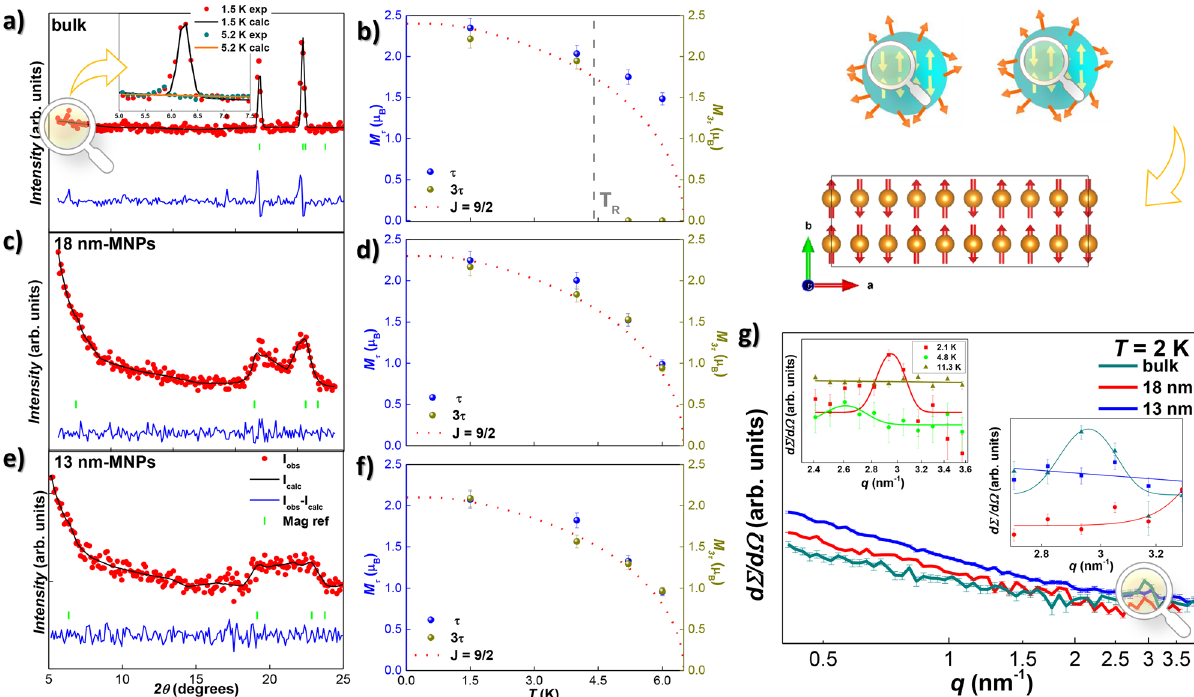
Figure 1. Neutron diffraction results. ( a , c , e ) Experimental neutron diffraction patterns at T = 5.2 K (red dots), together with the Rietveld refinements (black lines) measured for bulk NdCu 2 , 18 nm and 13 nm-sized MNPs, respectively. Inset in ( a ) zooms the commensurate (200) magnetic reflection, present at T = 1.5 K, and absent at T = 5.2 K. ( b , d , f ): Temperature dependence of the magnetic moment M per unit cell. The position of the commensurate-to-incommensurate transition temperature is only marked for the bulk alloy [vertical gray dashed line in ( b )]. ( g ) Differential SANS cross section d �/ d � as a function of the momentum transfer q (log– log scale) measured for bulk (dark cyan), 18 nm (red), and 13 nm-sized (blue) NdCu 2 MNPs at zero field and at T = 2 K (commensurate AF phase). Right inset zooms into the region nearby 2.6 (cid:31) q (cid:31) 3.3 nm − 1 at T = 2 K. This region has been studied at T = 2.1 K and 4.8 K (incommensurate AF phase) and at 11.3 K (paramagnetic phase) for the bulk alloy (top left inset). Sketches of the MNPs and of commensurate magnetic structure are showed on the top